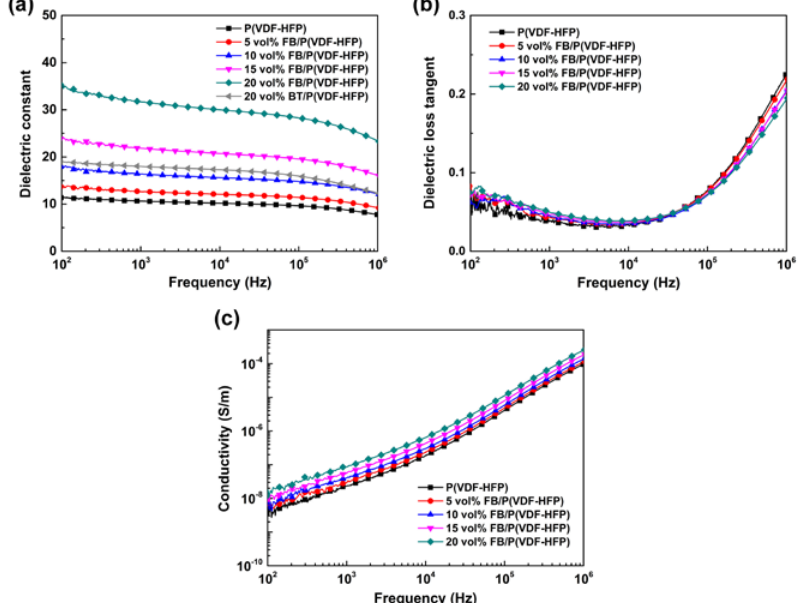
Figure 7. Frequency dependence of ( a ) dielectric constant, ( b ) dielectric loss tangent, and ( c ) conductivity of pristine polymer, BT/P(VDF-HFP), and FB/P(VDF-HFP) composites.